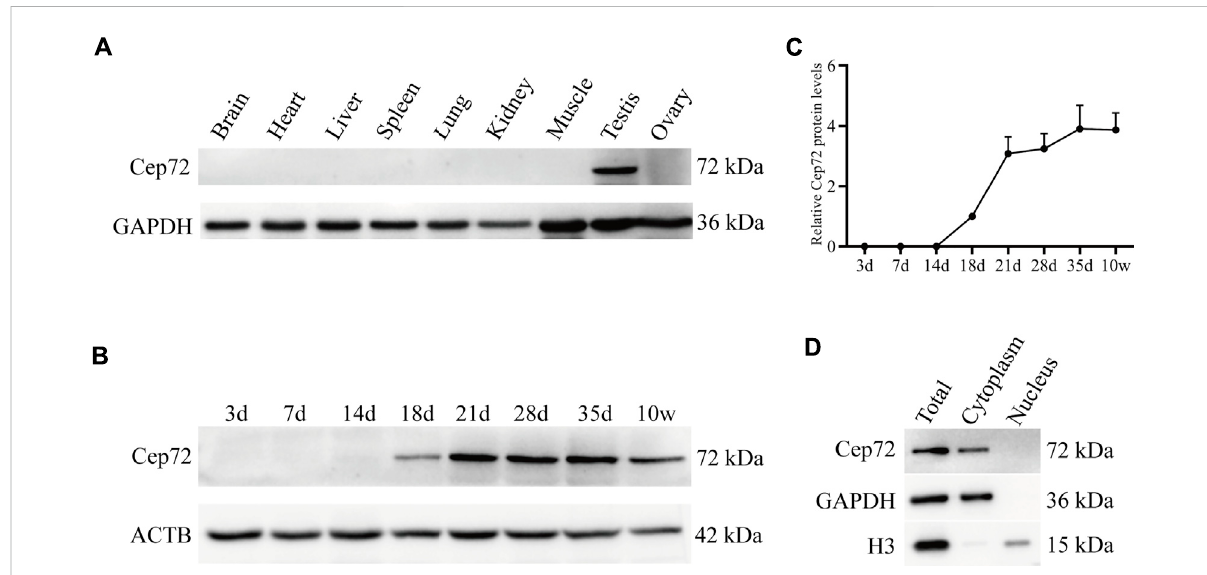
FIGURE 1 Expression patterns of Cep72 protein in mice. (A) Western blot displayed the protein pro fi ling of Cep72 in multiple tissues. GAPDH was used as aninternalcontrol. (B) WesternblotshowedtheproteinexpressionofCep72intestesofmicewithvariouspostnataldays. ACTB